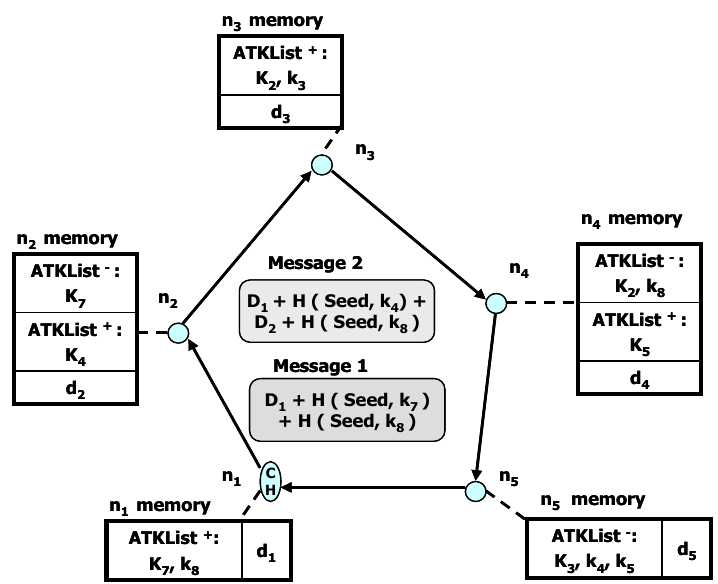
Figure 3. Data aggregation with shadow values.